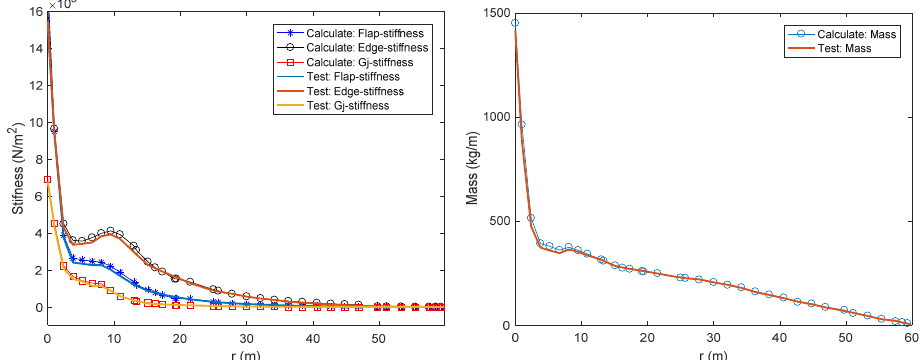
Figure 3. Comparison between the stiffness and mass per unit length distributions obtained by CLT code and actual blade.